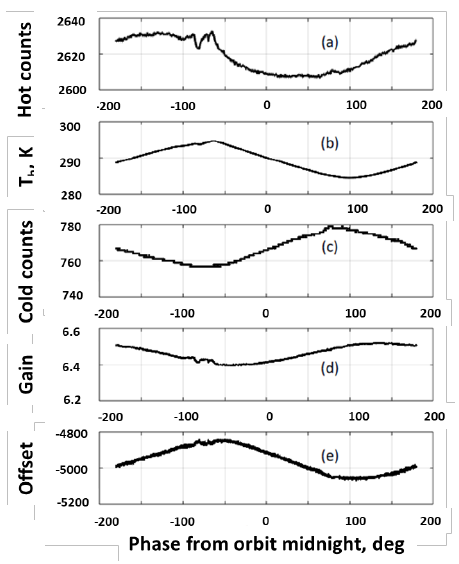
Figure 4. TMI parameters for 10.65 V channel during TRMM orbit # 87736: ( a ) hot counts, ( b ) measured hot load physical temperature, ( c ) cold counts, ( d ) receiver gain and ( e ) receiver offset.